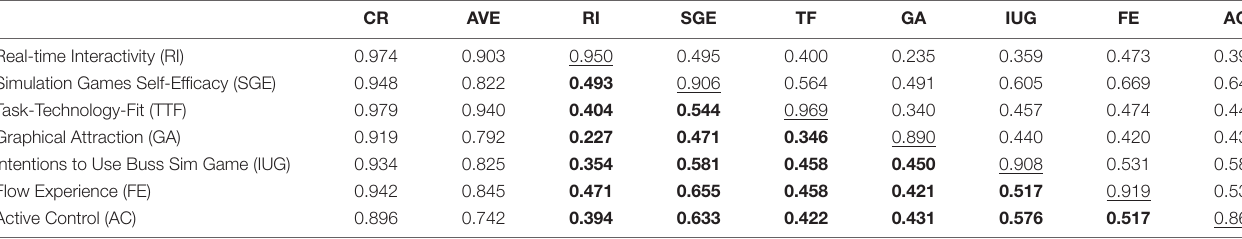
TABLE 4 | Composite reliability, average variance extracted, and heterotrait-monotrait testing. CR AVE